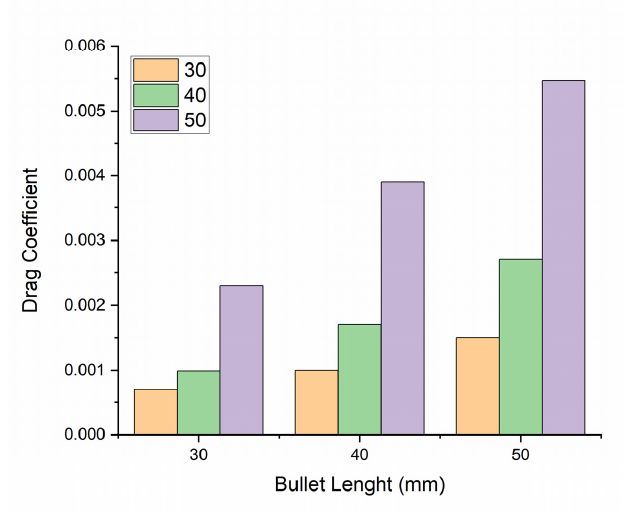
Figure 7. Simulated values of drag coefficient of 30 mm, 40 mm, and 50 mm bullet heads (design I) at 30 ◦ ,40 ◦ , and 50 ◦ angle of attack.